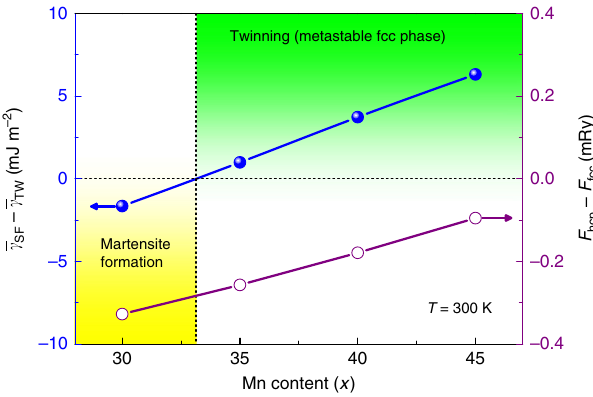
Fig. 1 Composition-dependent effective energy barrier difference (cid:1) (cid:3) (cid:1) γ for the Fe 80 − x Mn x Co 10 Cr 10 alloys at room-temperature. (cid:2) (cid:1) γ (cid:1) (cid:3) SF TW Negative (cid:1) γ indicates hcp martensite formation (yellow area), (cid:2) (cid:1) γ SF TW while positive one implies twinning (green area). Open circles denote the F structural energy difference ( F ), where F and F are the free hcp (cid:2) fcc hcp fcc energies of hcp and fcc structures, respectively